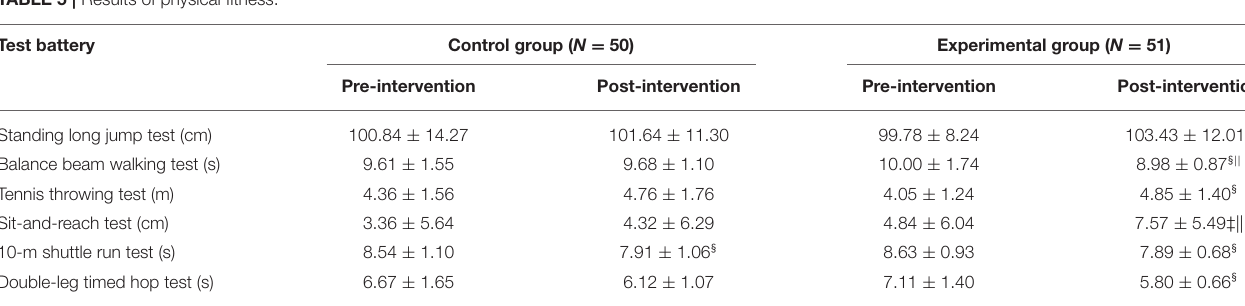
TABLE 5 | Results of physical fitness.